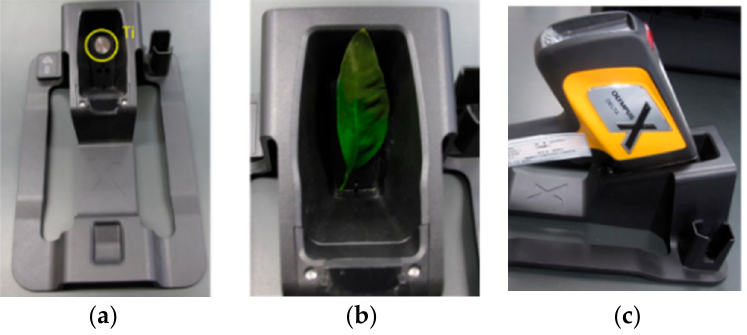
Figure 6. Special measurement station for leaf: ( a ) Titanium coin used instead of iron; ( b ) special measurement station for the leaves; ( c ) hXRF analyzer used in this study.